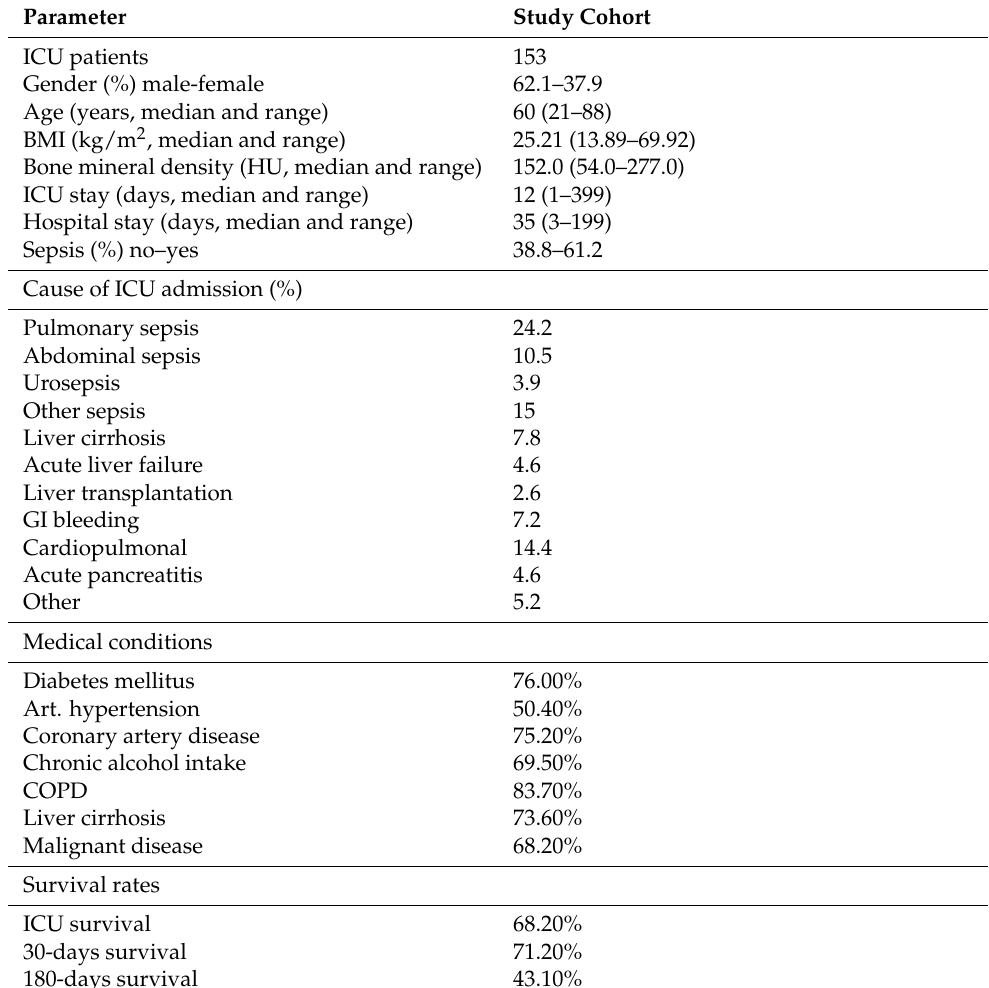
Table 1. Characteristics of study cohort. BMI: body mass index, COPD: chronic obstructive pul- monary disease, GI: gastrointestinal, ICU: intensive care unit, HU: Hounsfield